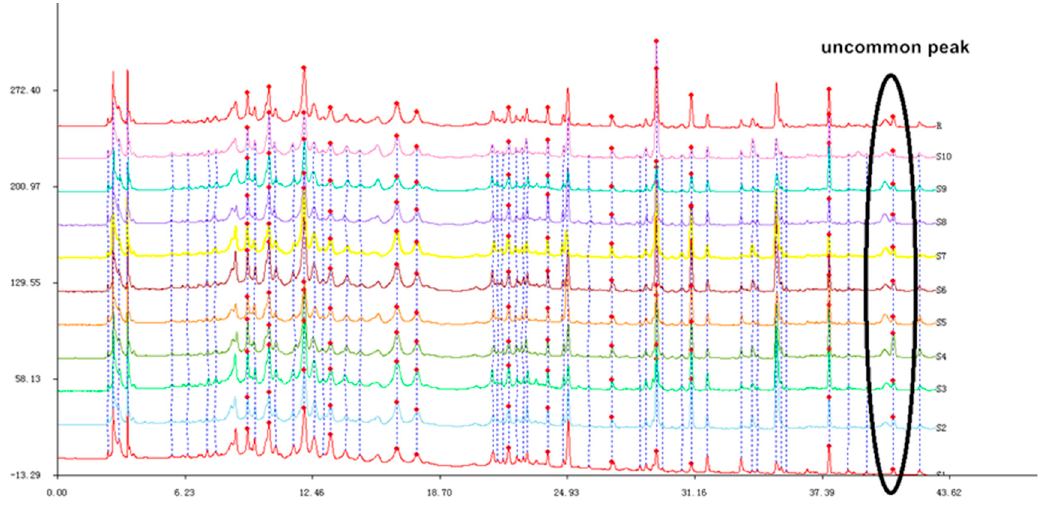
Figure 4. The chromatographic fingerprint of 10 T. patula samples (S1–S10).